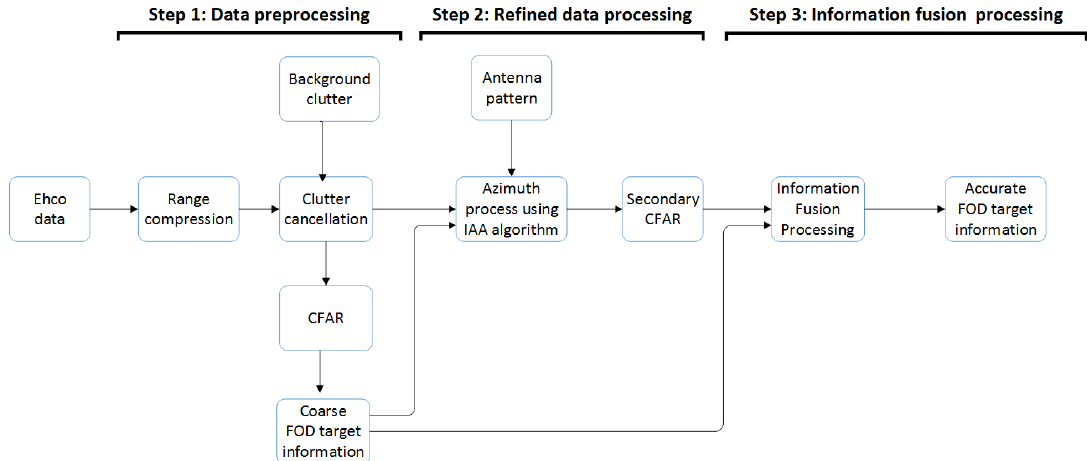
Figure 3. Flowchart of the FOD radar processing chain for the proposed method.